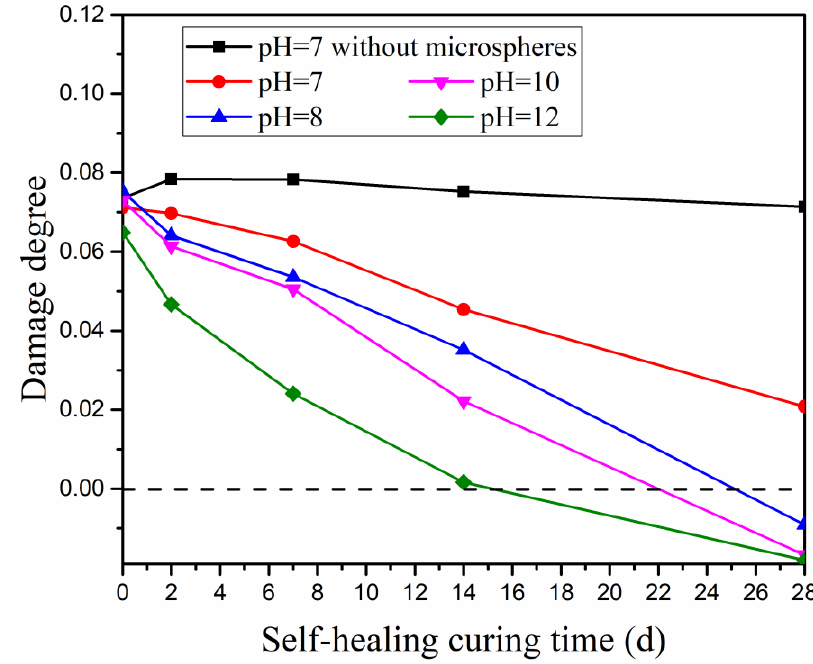
Figure 8. Influence of different alkaline environments on damage degree.